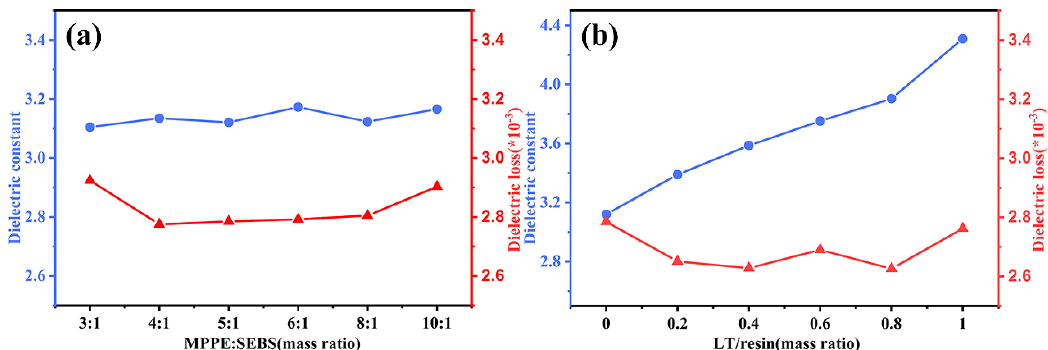
Figure 8. Dielectric constant and dissipation factors of ( a ) P-CCLs and ( b ) LT-CCLs.